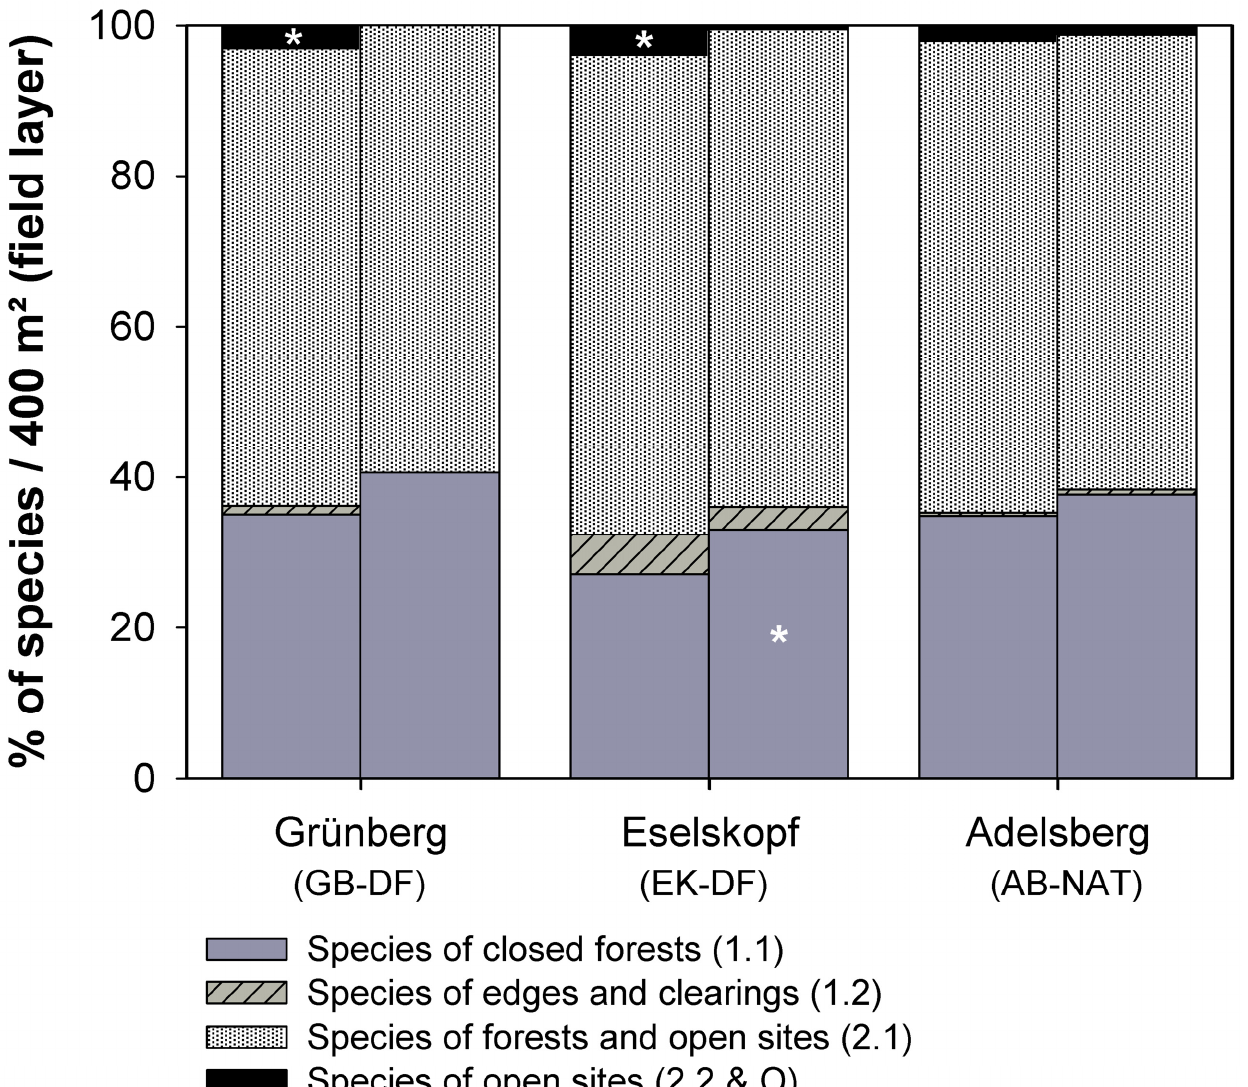
Figure 1. Percentage share of species of the field layer grouped according to their forest affinity in the three strict forest reserves. Left column = old survey, right column = recent survey. * marks significant differences between surveys ( p <